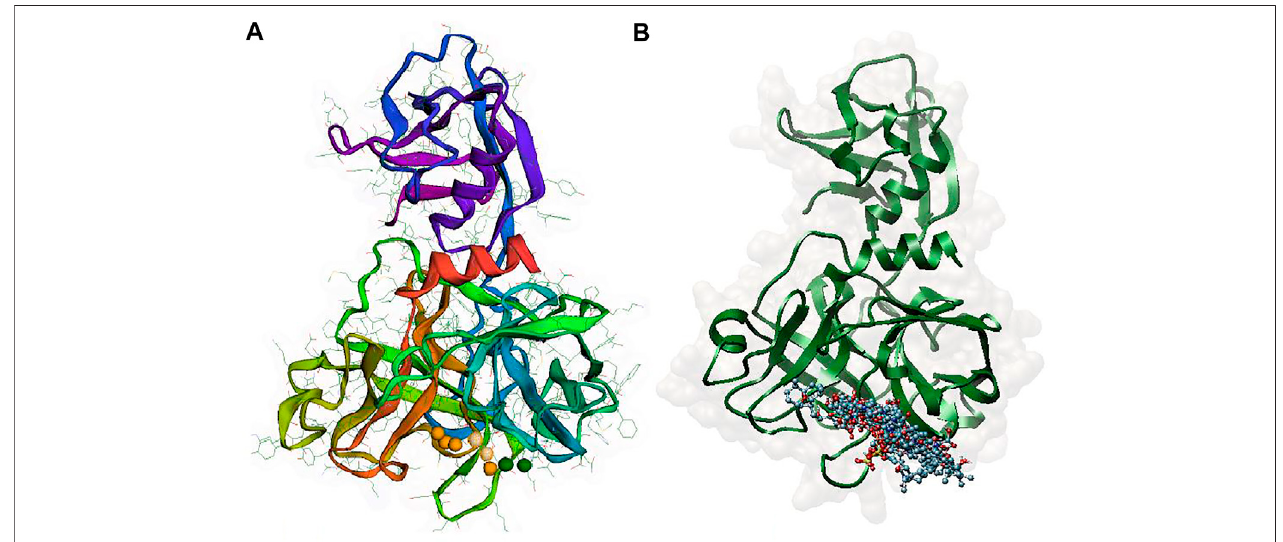
FIGURE3|(A) PharmacophoremodelgeneratedbythePharmitserver,Twoamidenitrogenatomstorepresenthydrogenbonddonors(DON)(greensphere),four negatively charged oxygen atoms (as in a carboxyl group) to represent a hydrogen bond acceptor (ACC) (orange sphere), and the two isopropyl group to represent a hydrophobic center (HYD) (yellow sphere) (B) superposition of all 11 aligned lead MNPs according to pharmacophore model.